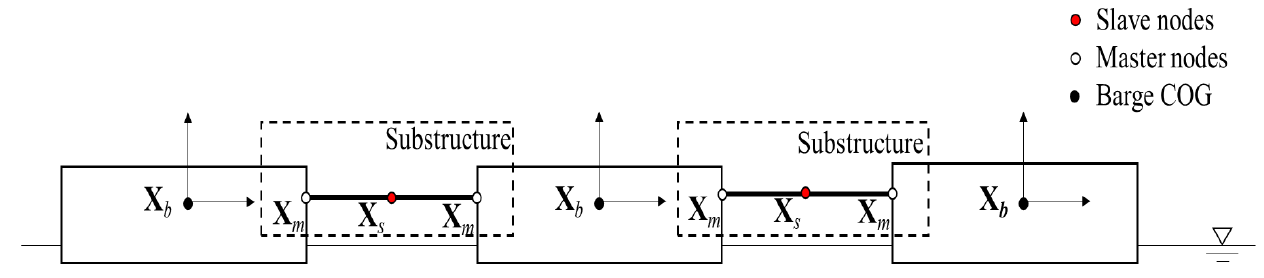
Figure 1. Dynamic model with flexible substructures.